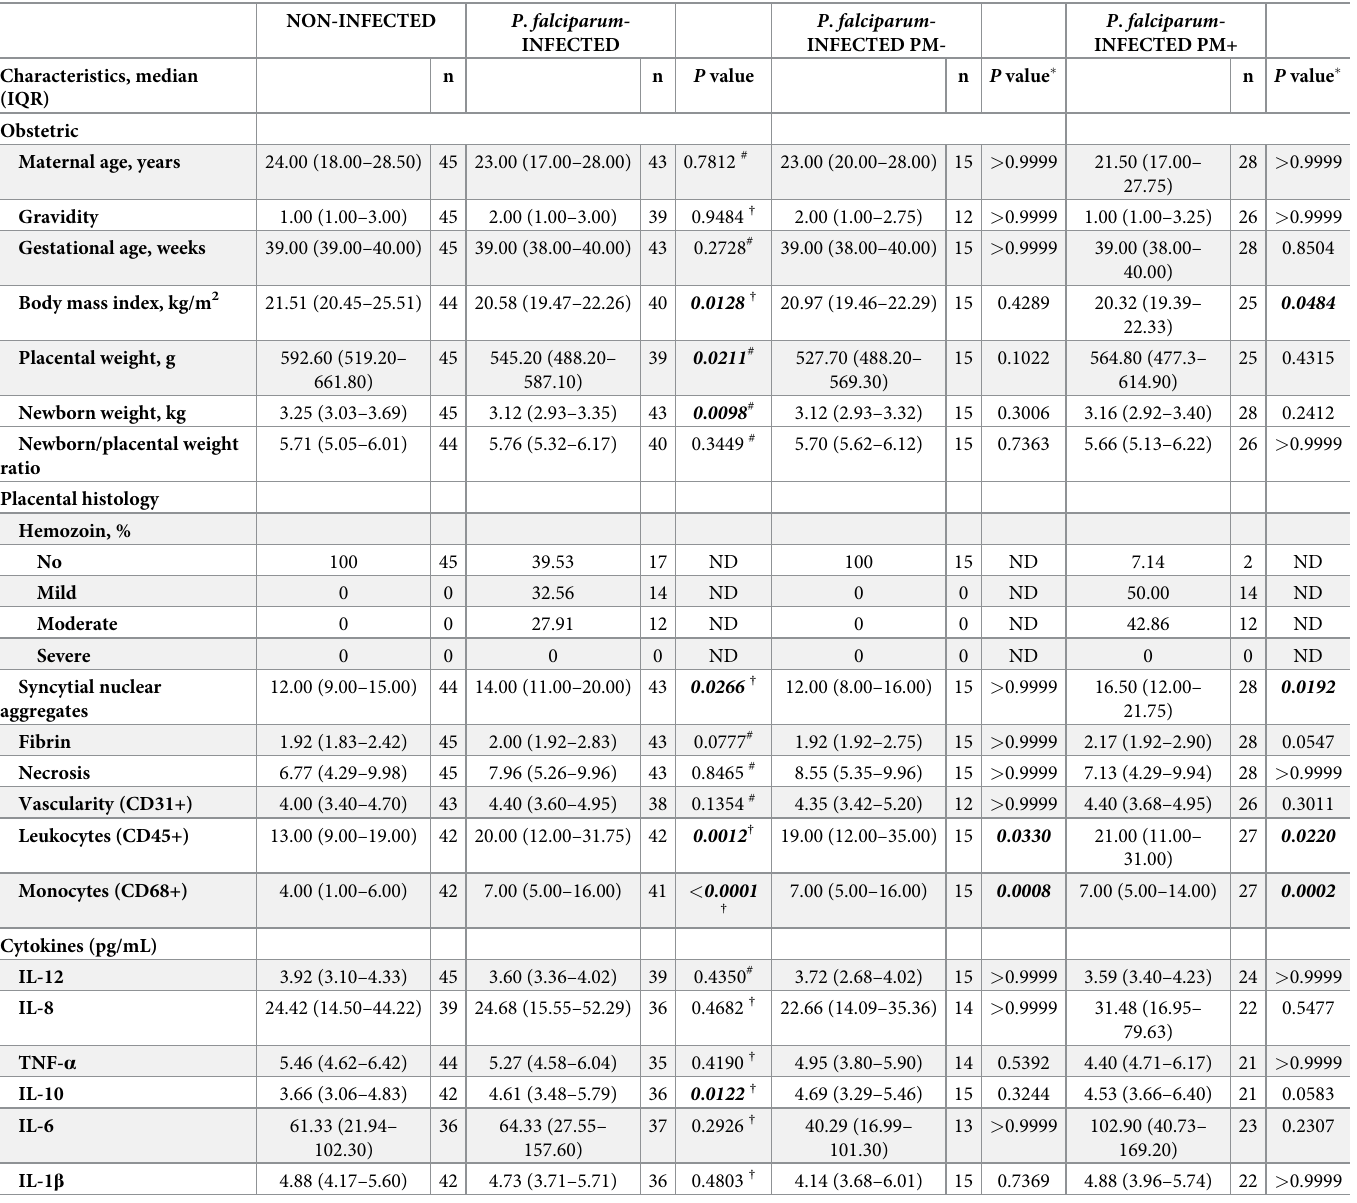
Table 1. Characteristics of pregnant women enrolling the study according to infection status.